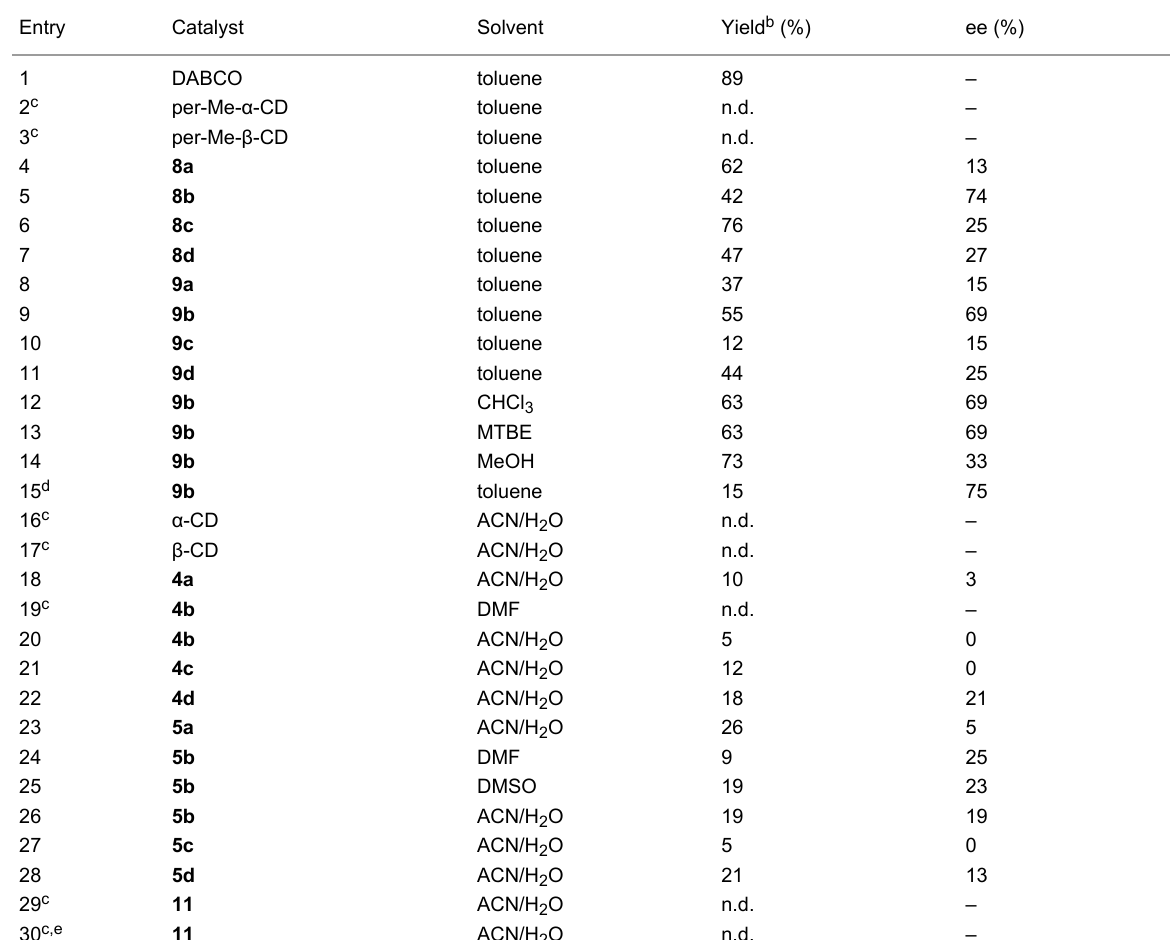
Table 3: Catalytic activity of the CD derivatives in the AAA reaction of MBH carbamate 12 .